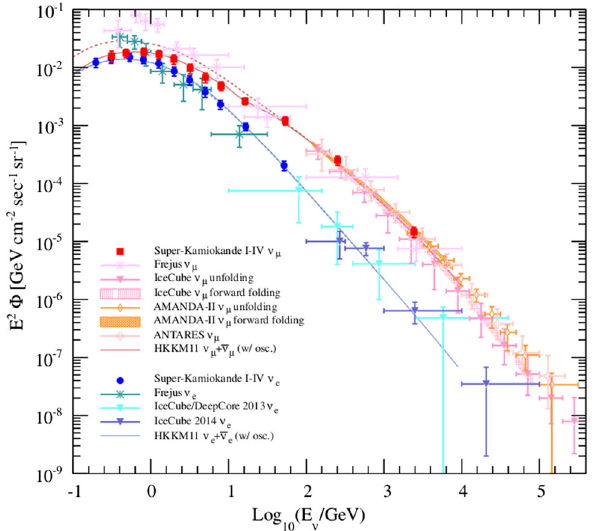
Fig. 1 Presentmeasurementsoftheatmosphericneutrinoenergyspec- trum, compared with theoretical predictions. Data and models are reported separately for ν e and ν μ . Figure from [7]